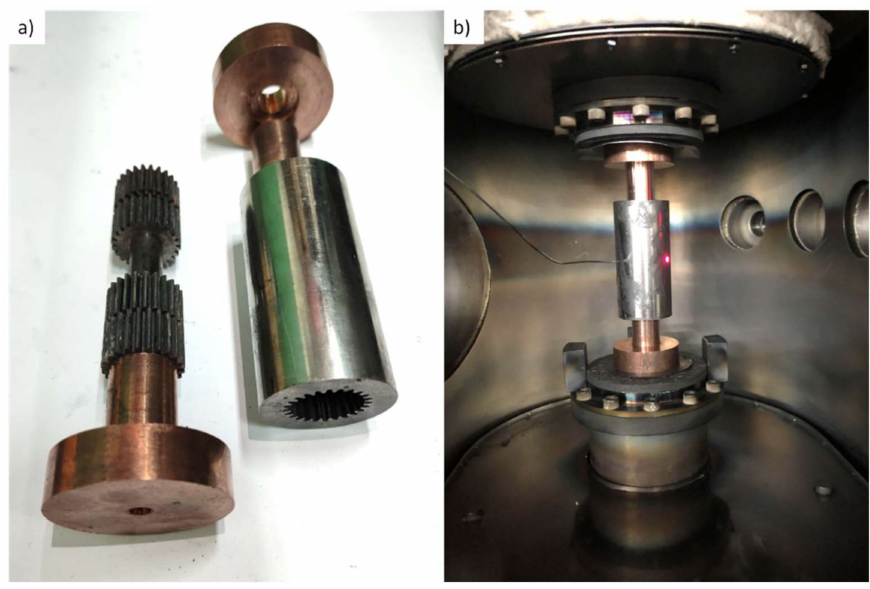
Figure 2. Die assembly for gear wheel sample manufacturing ( a ) an exploded view of the die assembly and ( b ) processing die in U-FAST